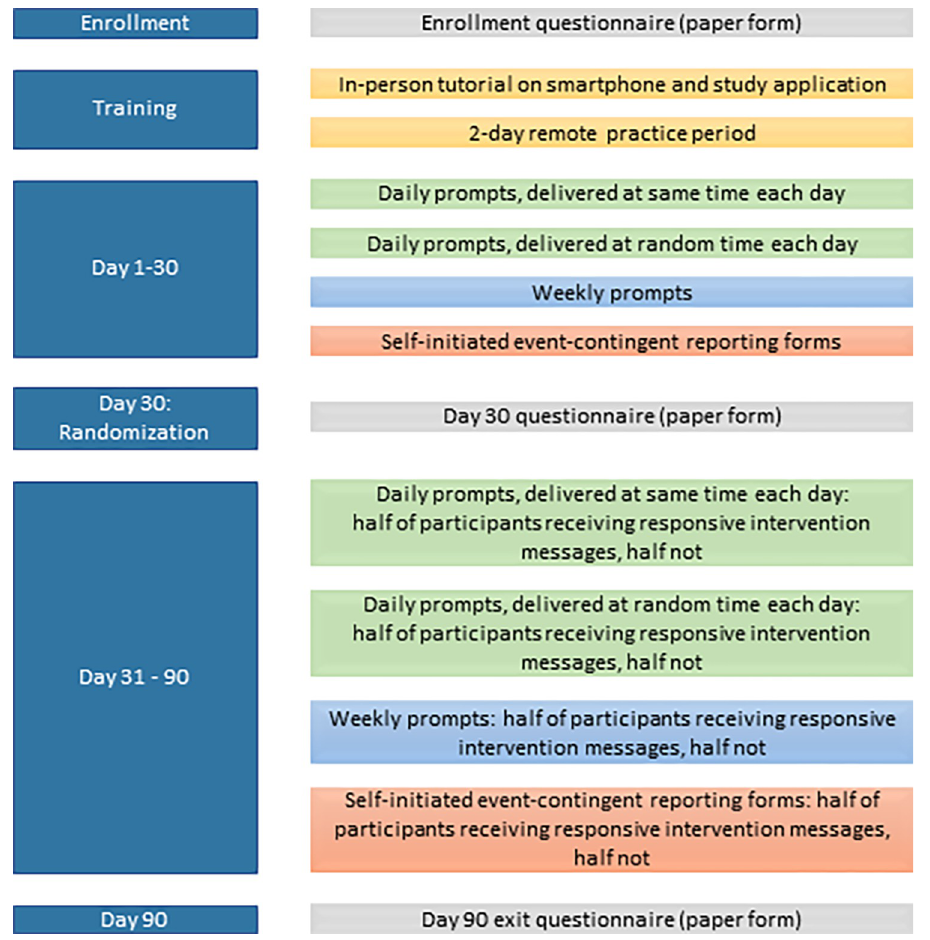
Fig 1. Study design. Figure partially reproduced from Beres et al, JMIR Form Res., 2021, https://doi.org/10.2196/ 22693.